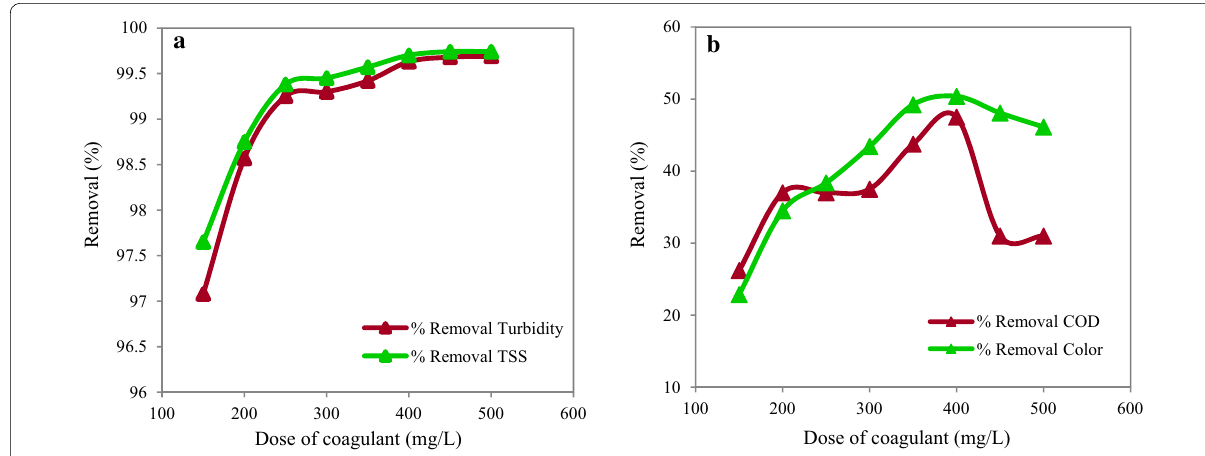
Fig. 4 Removal efficiency of turbidity, TSS ( a ) and COD, color ( b ) for different doses of coagulant from wastewater (at optimum pH